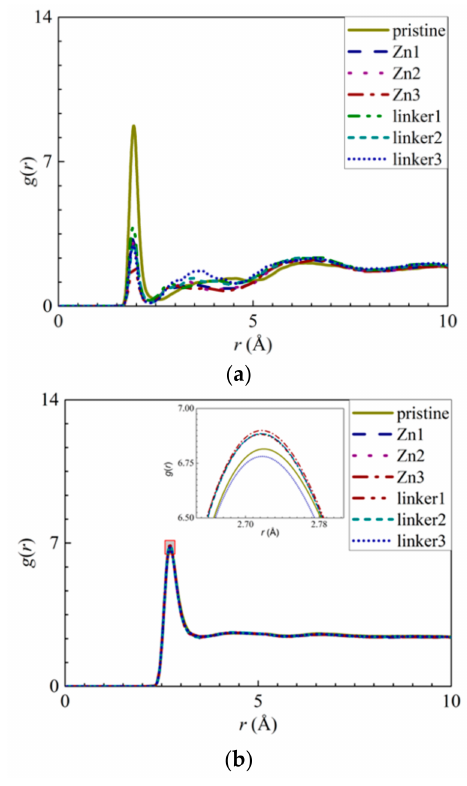
Figure 11. RDFs of the O atoms of water molecules surrounding the respective atoms: ( a ) Zn atoms and ( b ) other O atoms of water molecules. The inset in ( b ) presents an enlarged view of the first peak, as delineated by the shaded